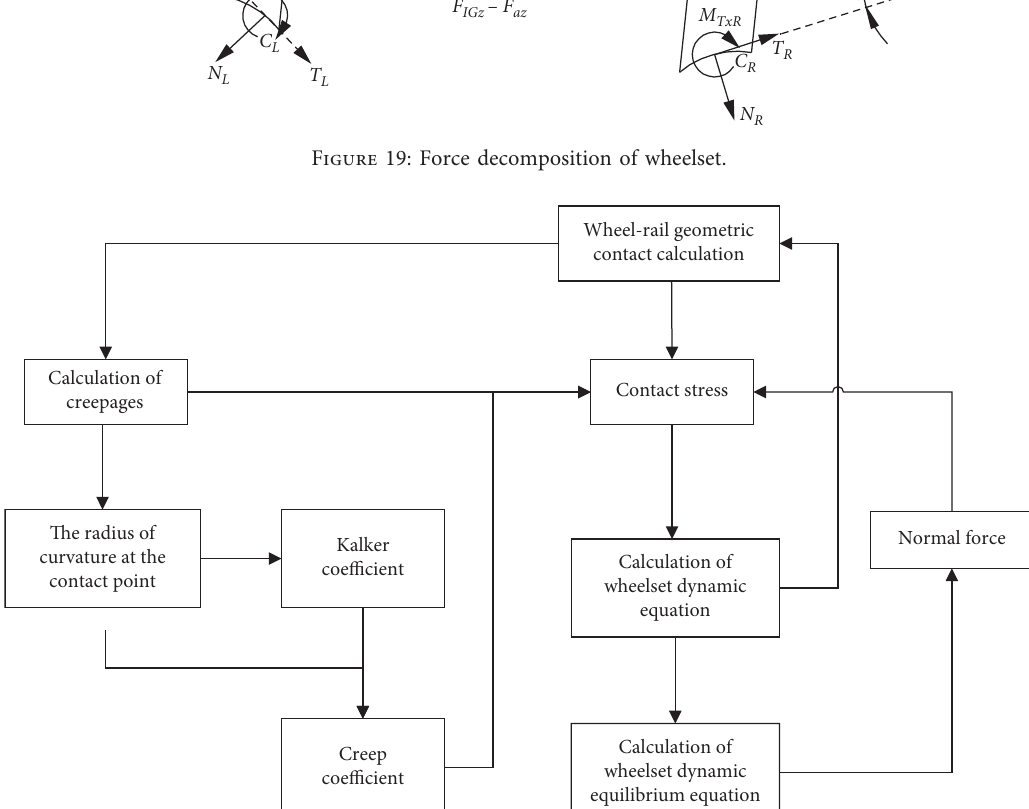
Figure 20: Flowchart of wheel-rail creep.